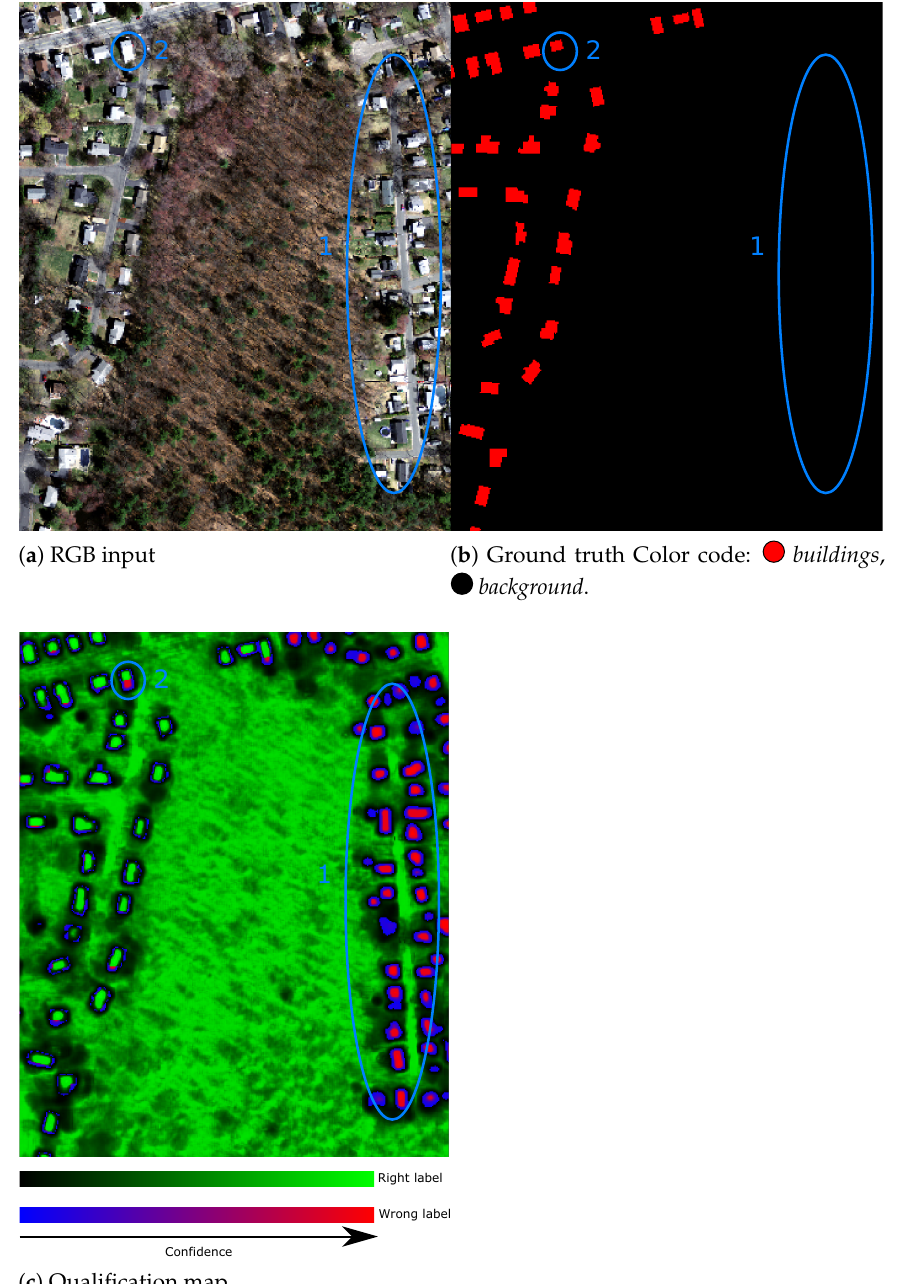
Figure 9. Visual results of our Bayesian U-Net on a small area of the Massachussets dataset. Blue circles correspond to: (1)-Building missing in the database, (2)-Incomplete building